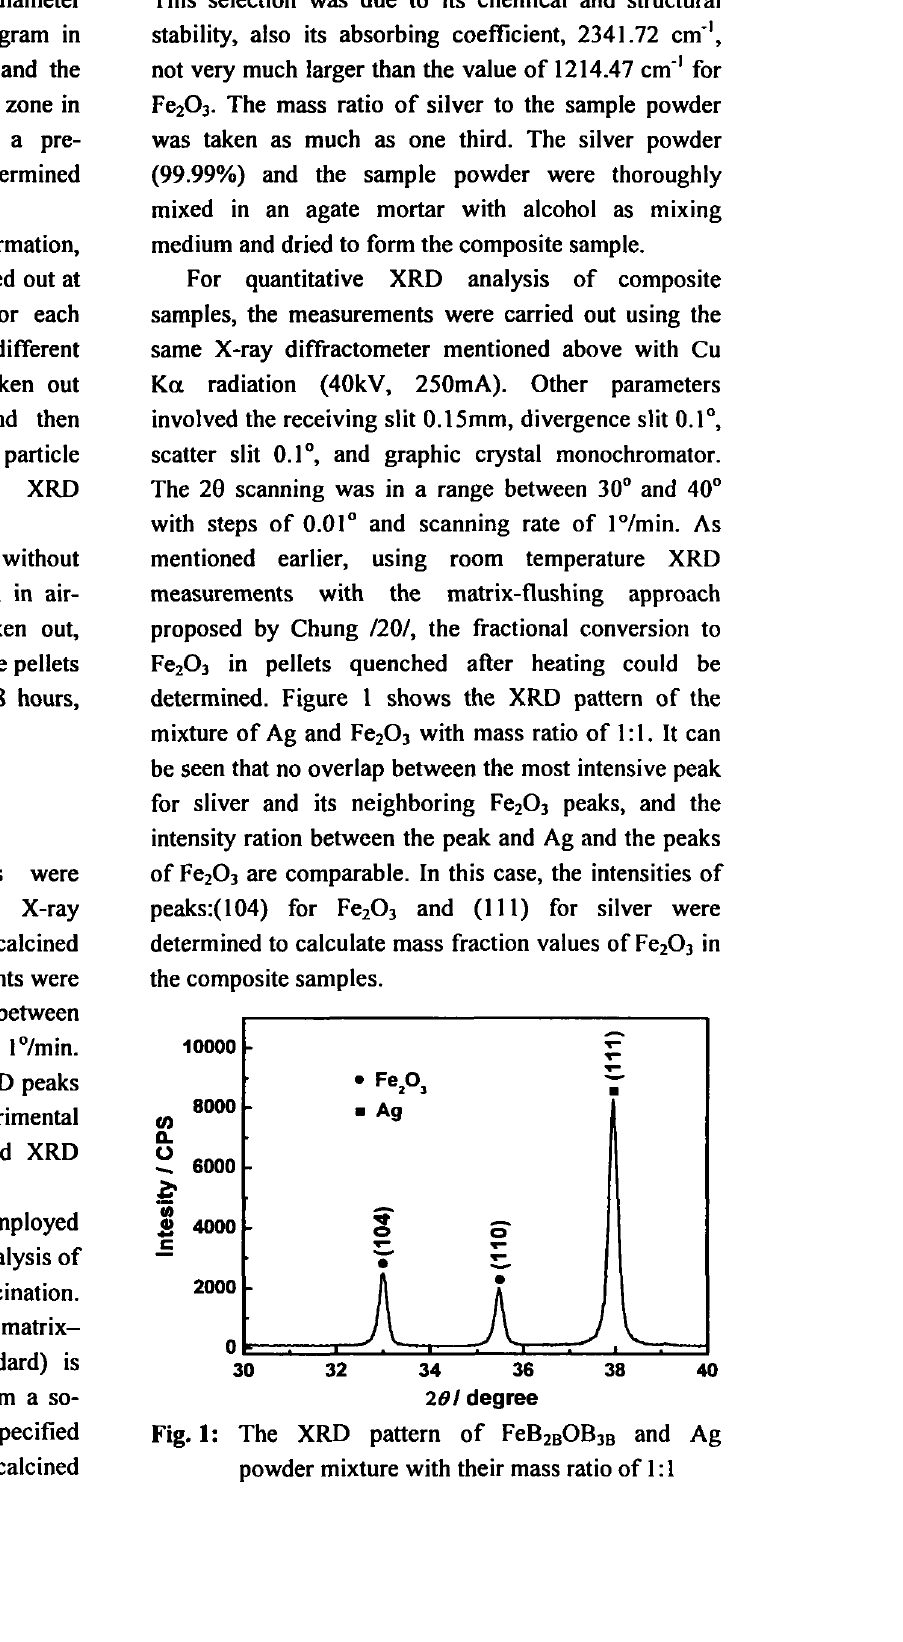
OB and Ag 2B 3B